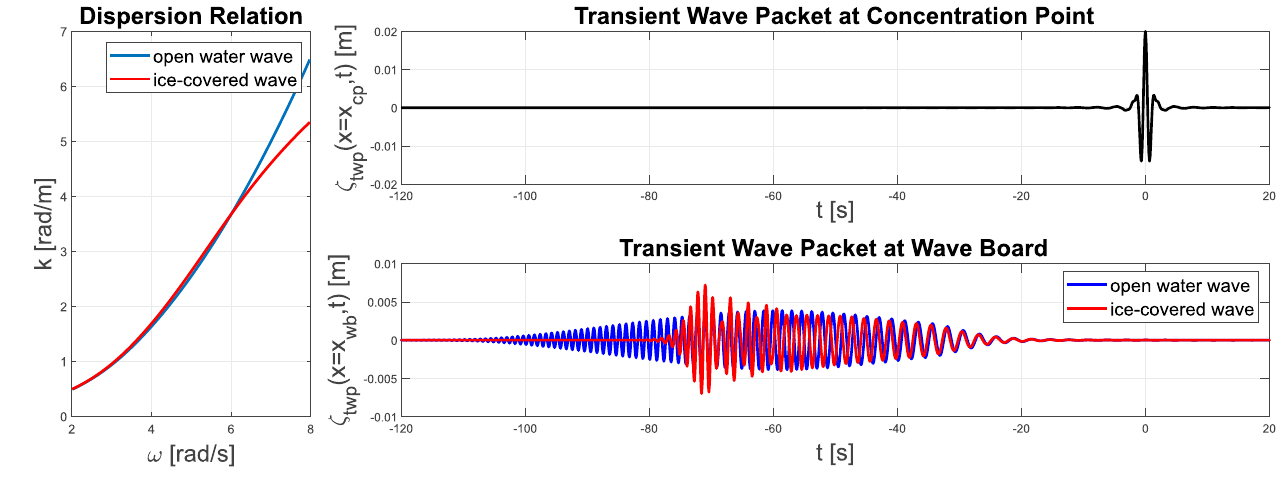
Figure 8. Overview of the TWP concept [47]. Table 2. Wave properties at which ice breaking is observed.